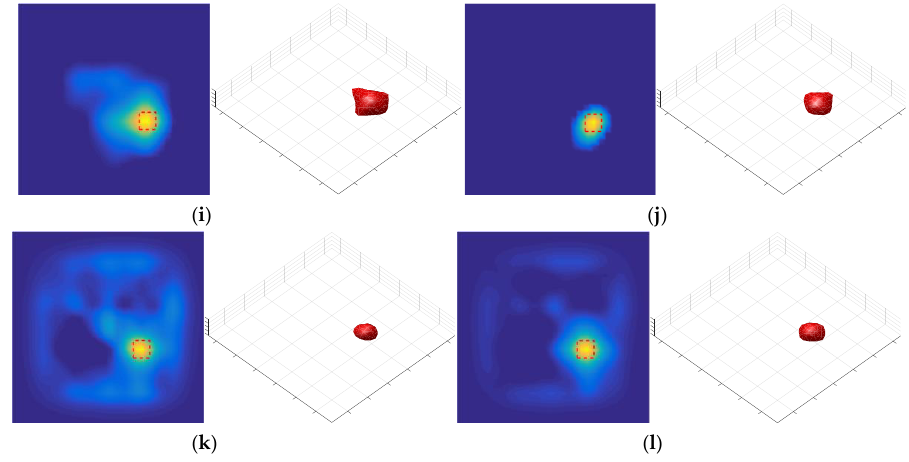
Figure 13. Image reconstruction results in 2D and 3D under conditions of different material thickness, Figure ( a , c , e , g , i , k ) are 66-measurement capacitance data reconstruction results with thickness of 15 mm, 20 mm, 25 mm; Figure ( b , d , f , h , j , l ) are 29-measurement capacitance data reconstruction results with thickness of 15 mm, 20 mm, 25 mm. ( a ), ( b ) results of sample 4 with thickness of 15 mm; ( c ), ( d ) results of sample 5 with thickness of 20 mm; ( e ), ( f ) results of sample 6 with thickness of 25 mm; ( g ), ( h ) results of sample 8 with thickness of 15 mm; ( i ), ( j ) results of sample 9 with thickness of 20 mm; ( k ), ( l ) results of sample 4 with thickness of 25 mm.